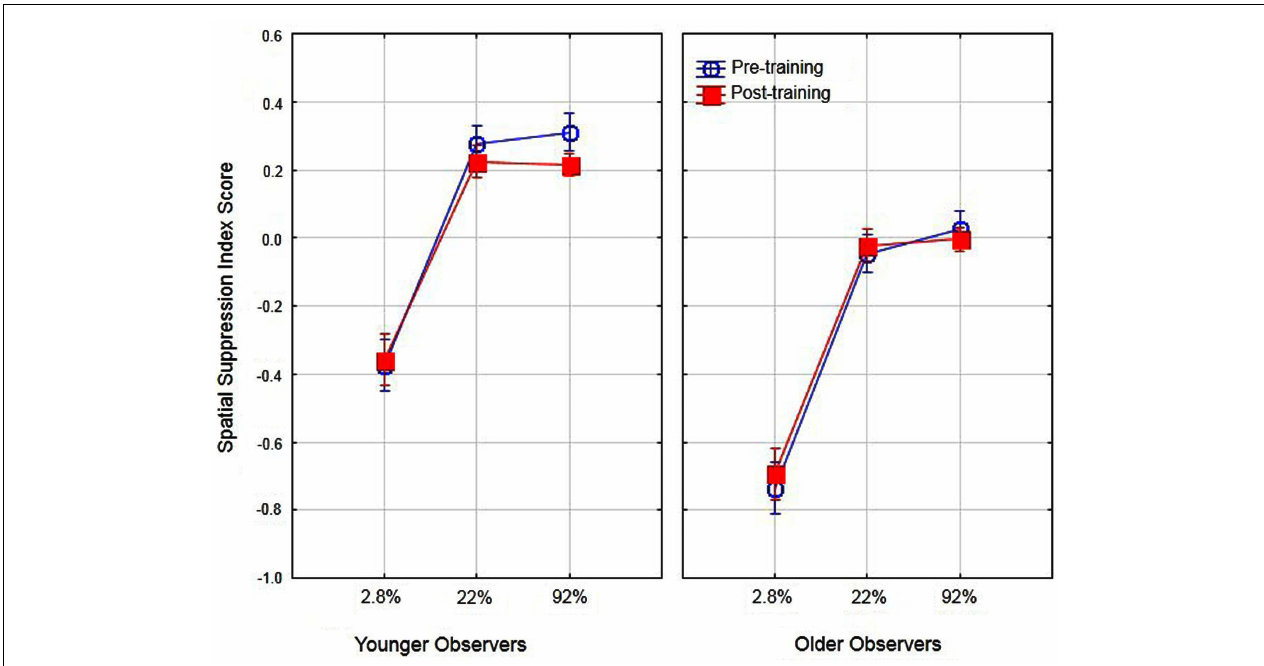
FIGURE 4 | Effects of training, contrast, and age on spatial suppression index scores. Error bars represent ± 1